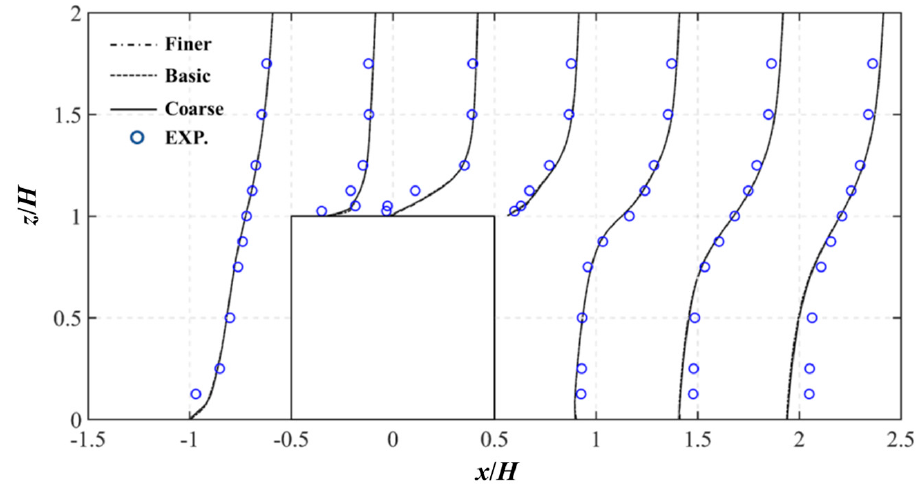
Figure 4. Streamwise velocity along seven vertical lines at a center vertical section for different meshes.